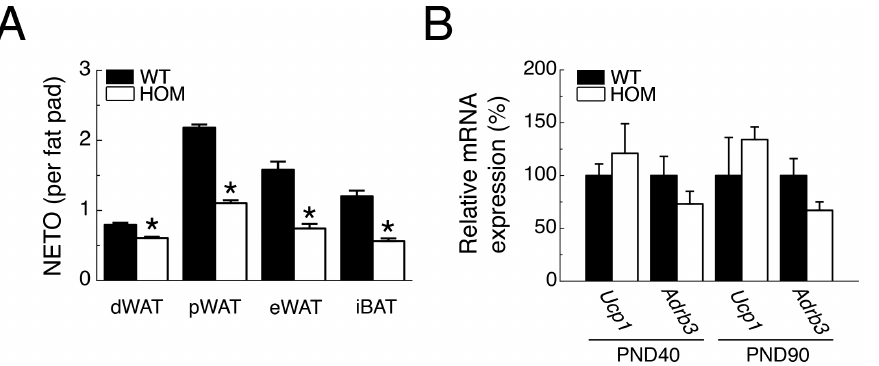
Figure 4. Pmch -deficiency lowers sympathetic adipose drive. ( A ) NETO in dWAT, pWAT, eWAT, and iBAT of WT and HOM rats at PND 153 (n=8–11/group). ( B ) Relative mRNA expression of Uncoupling Protein 1 ( Ucp1 ) and b 3-adrenoceptor ( Adrb3 ) in iBAT of WT and HOM rats at PND 40 (left) and 90 (right) (n=5–6/group). * P , 0.05 vs WT.